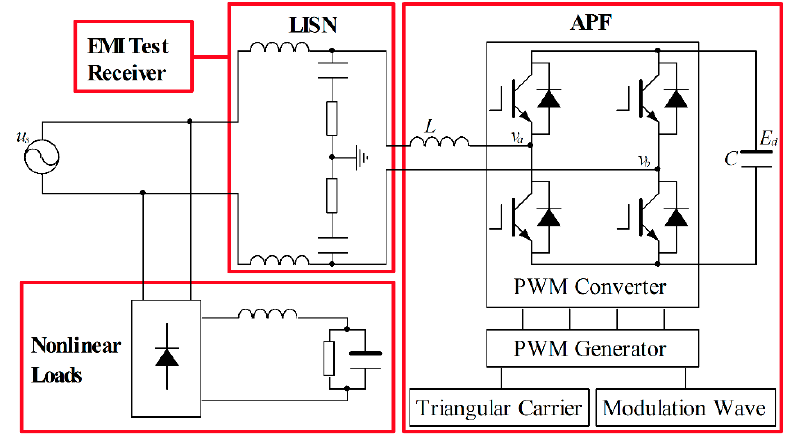
Figure 1. Topology and control diagram of the single-phase shunt APF.